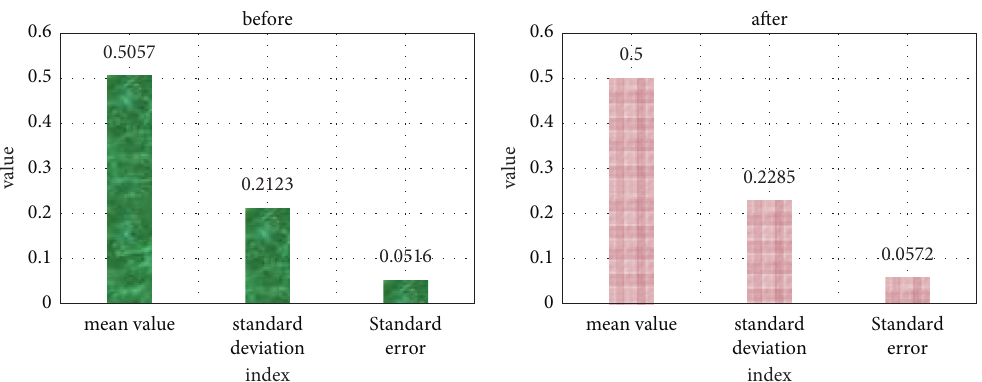
Figure 8: Sample statistics before and after